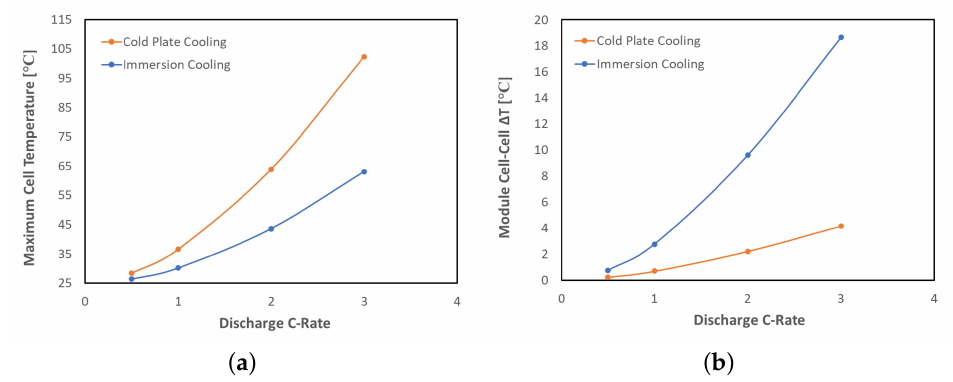
Figure 10. Effect of variation of discharge C-rate on ( a ) maximum cell temperature (°C), and ( b ) cell-to-cell temperature differential within the immersion-cooled and cold-plate-cooled modules